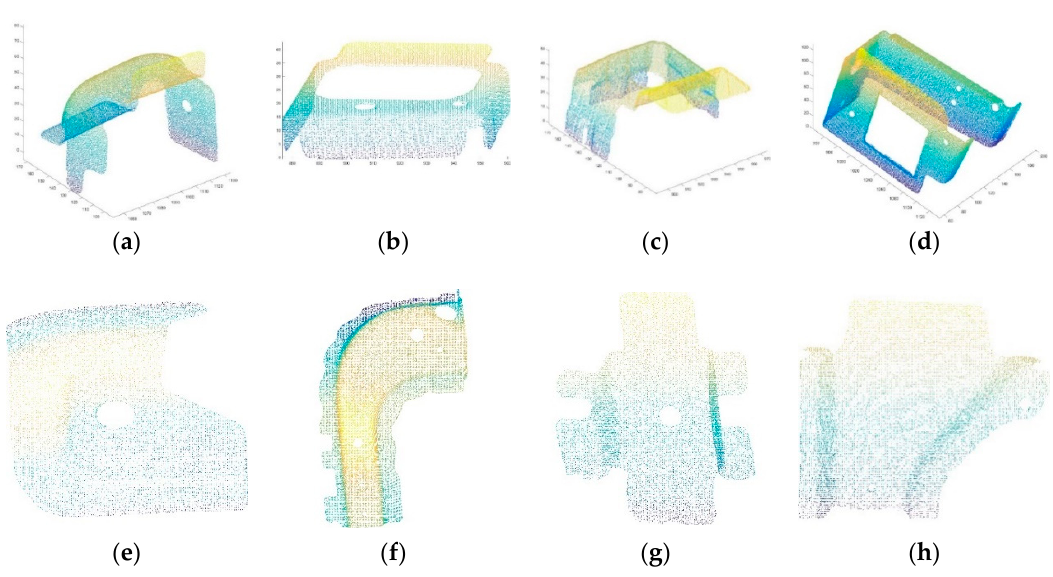
Figure 10. PCD after simplification in Figure 9. ( a )–( h ) are a series of simplification results of vehicle body parts PCD in Figure 9, respectively.